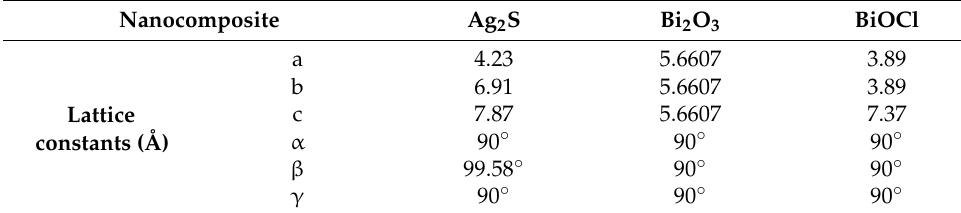
Table 1. Lattice parameters for Bi 2 O 3 , BiOCl, and Ag 2 S.